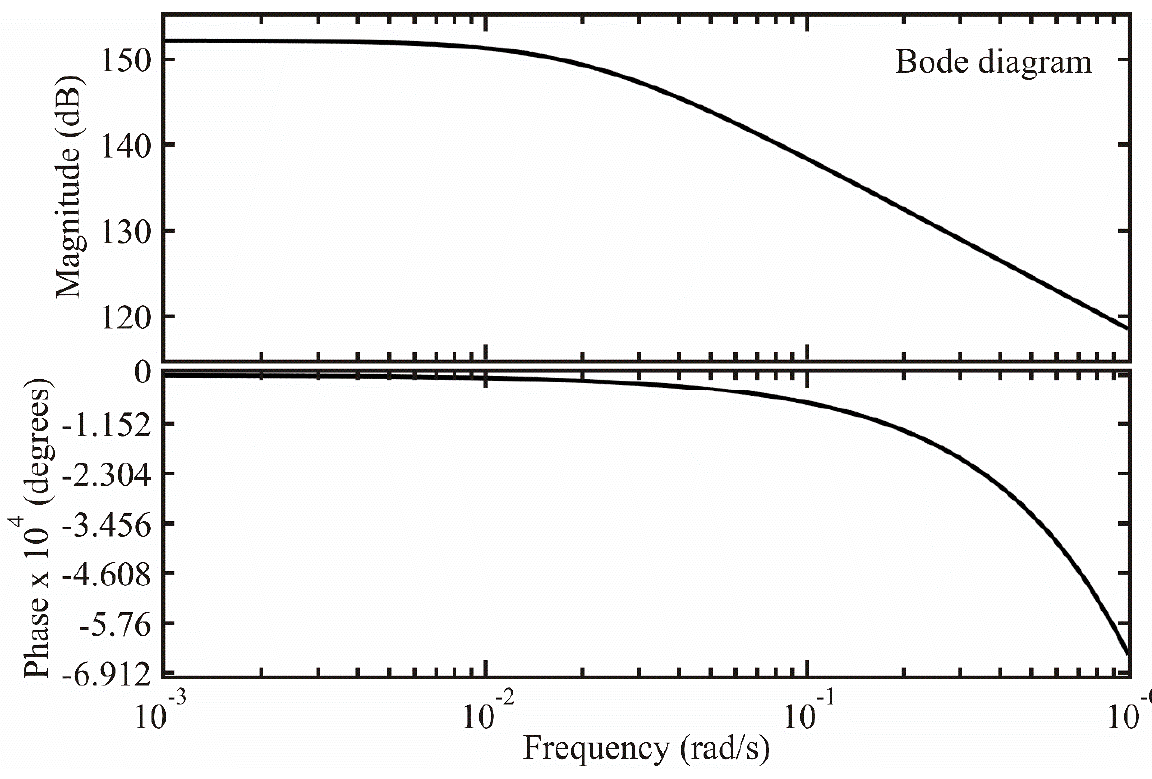
Figure 5. Frequency behavior of the ZnAl 2 O 4 sensor.